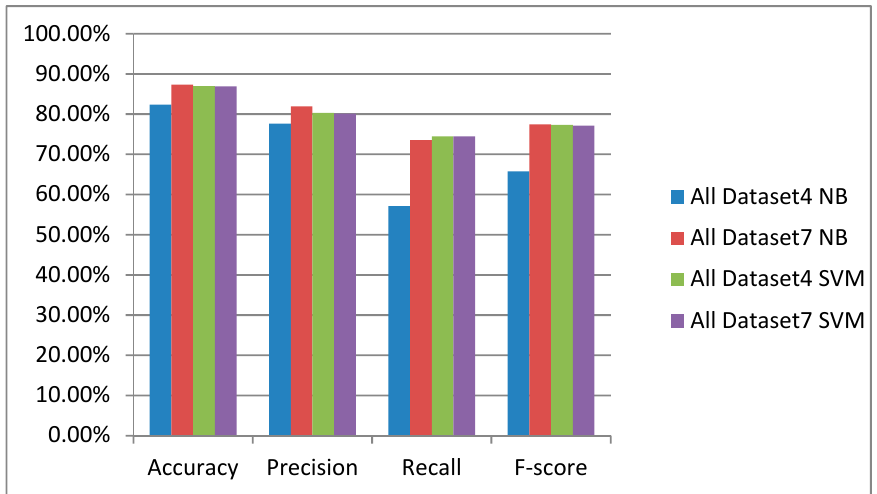
Figure 3. Graphical comparison of datasets 4 and 7 using Naïve Bayes (NB) and SVM on the All-Bordeaux data.